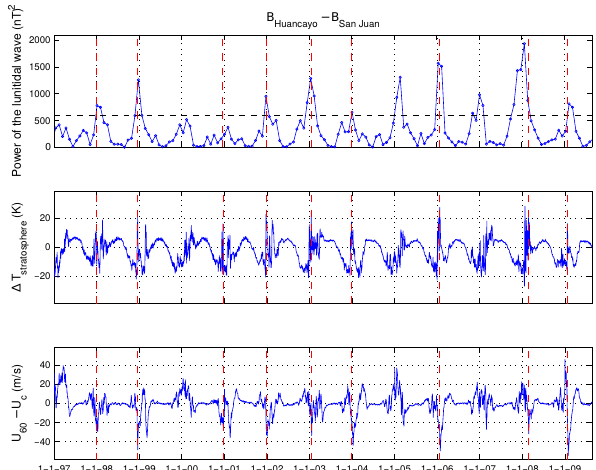
Figure 4. As Fig. 3, but for the period